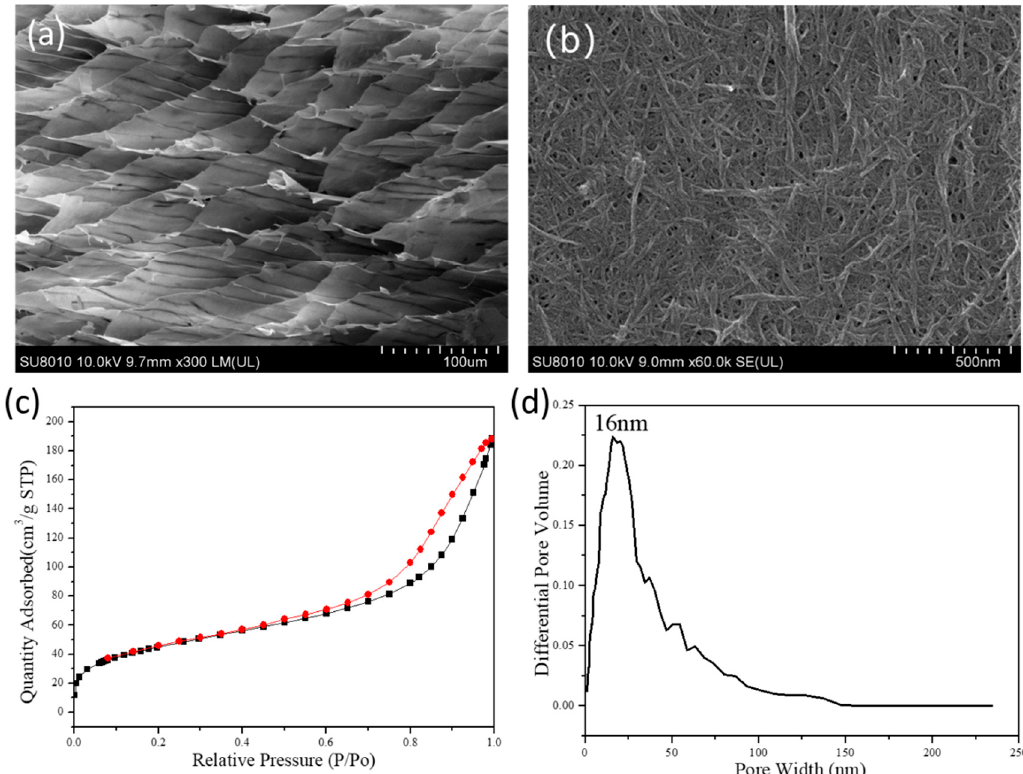
Figure 3. SEM images of the CNF Aerogel with progressively increased magnification: ( a ) honey comb porous structure, ( b ) mesoporous structure on the cell walls, ( c ) BET N 2 adsorption–desorption isotherm, and ( d ) pore size distribution of CNF Aerogel.